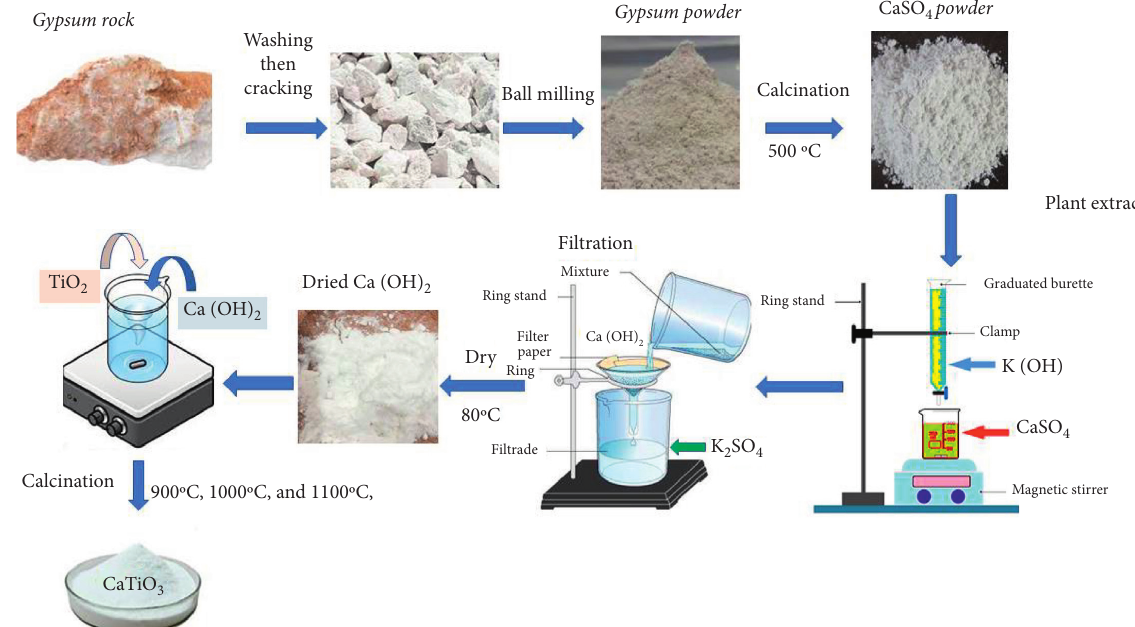
Figure 2: Preparation of CaTiO 3 powders via the sol-gel